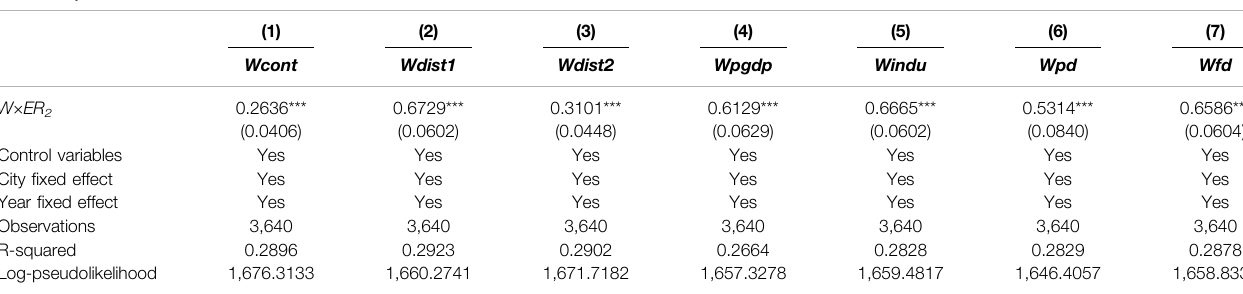
TABLE 9 | Estimates for the SO 2 removal rate.